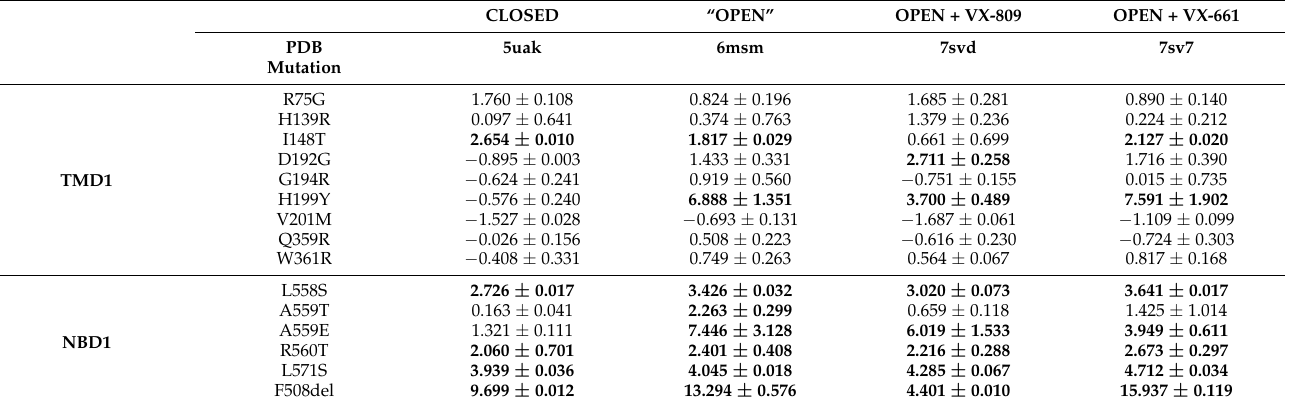
Table 1. Predicted ∆∆ G Values (( ∆ G(Mutant) − ∆ G(WT)) (kcal/mol) of 14 CFTR Mutations (9 in the TMD1 domain and 5 in the NBD1 domain) using FoldX [29]. For these calculations, the following structures were used as templates: dephosphorylated ATP-free human CFTR (PDB: 5uak) [7]; phos- phorylated ATP-bound human CFTR (PDB: 6msm) [28]; phosphorylated human CFTR + Mg/ATP + VX-809 (PDB: 7svd) [22] and phosphorylated human CFTR + Mg/ATP + VX-661 (PDB: 7sv7) [22]. Values of ∆∆ G > +1.84 kcal/mol are shown in bold. CLOSED “OPEN” OPEN + VX-809 OPEN + VX-661 PDB 5uak 6msm 7svd 7sv7